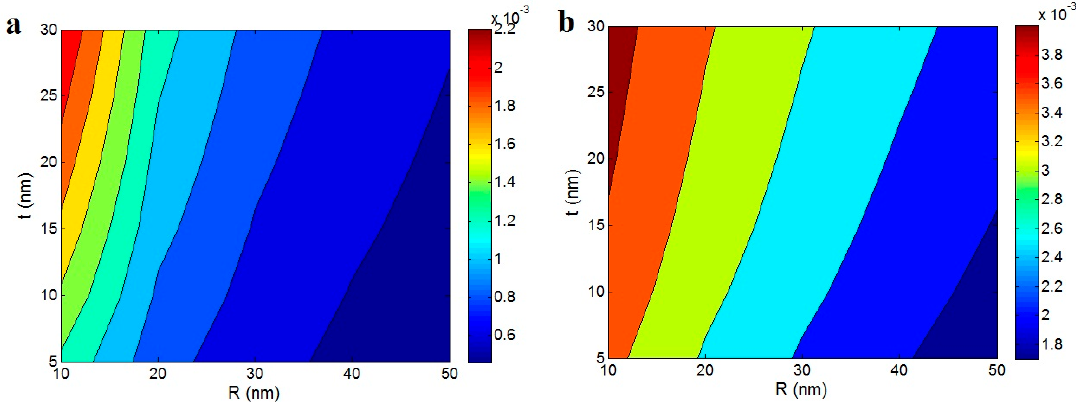
Figure 7. The “ φ N ” as a function of “ R ” and “ t ” parameters at φ f = 0.02, l = 5000 nm and A = 0.02 based on the “ f ” estimations of ( a ) Equation (12) and ( b ) Equation  ” as a function of “ R ” and “ t ” parameters at Figure 7. The “ N based on the “ f ” estimations of ( a ) Equation (12) and ( b ) Equation (13).